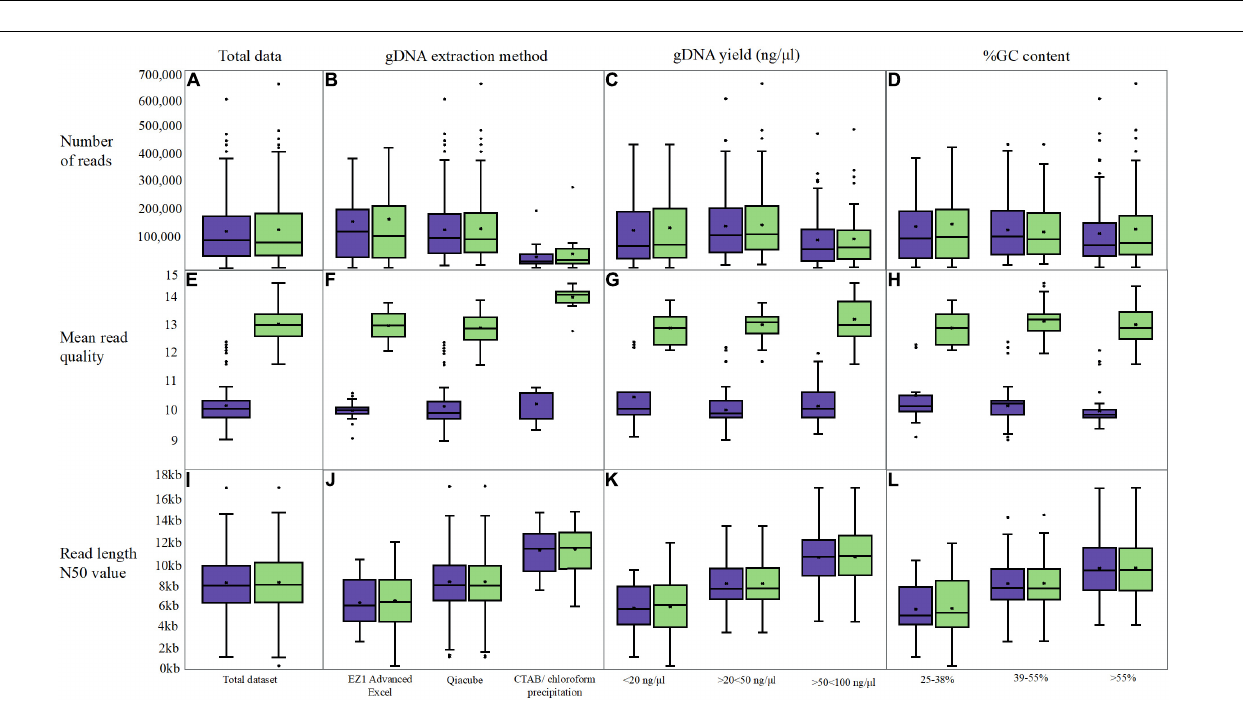
FIGURE 4 | Box and whisker plot s comparing original fastq metrics (purple) with FAST5 reads re-basecalled with Guppy v5.0.11 (green). Three long-read metrics were assessed; number of reads (A–D) , the mean read quality (E–H) and the read length N50 value (I–L) In addition to assessing overall read metrics following re-basecalling (A,C,I) , data was grouped into categories for gDNA extraction (B,F,J) , the gDNA yield (C,G,K) and the %GC content (D,H,L).